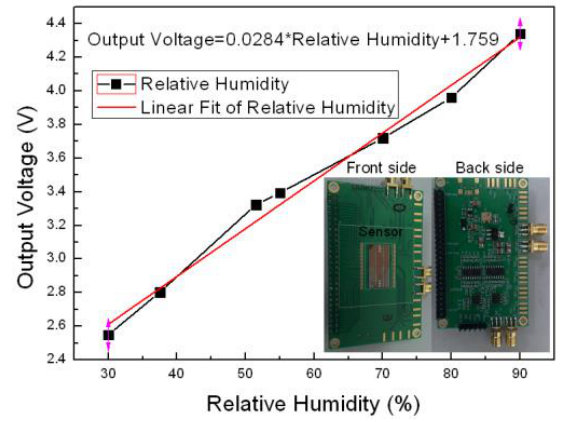
Figure 12. Output voltage vs RH value of the sensor structure .